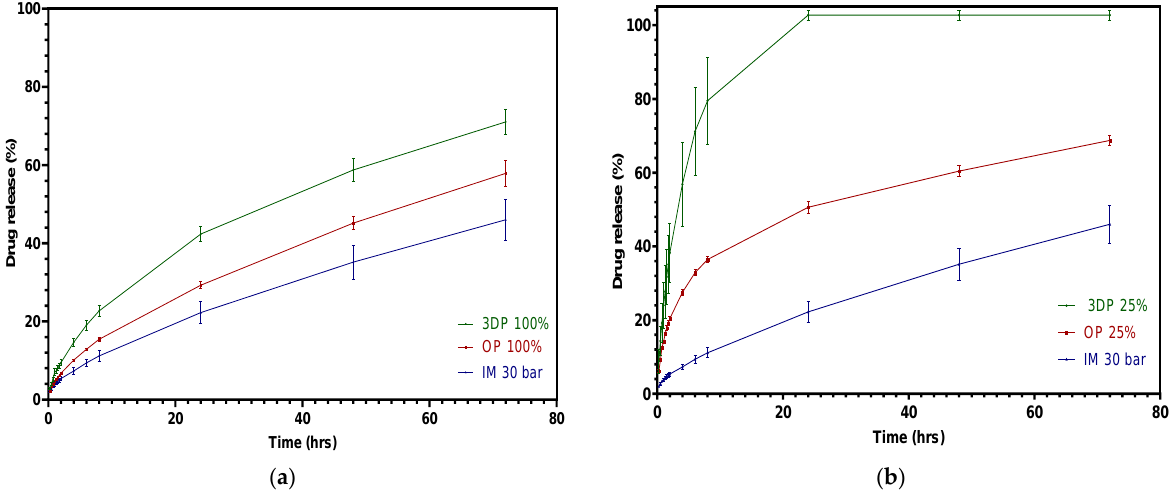
Figure 15. Cumulative theophylline release over 24 h in HCl-KCl pH 1.2 media for tablets: comparison among three different manufacturing approaches. ( a ) Slowest; ( b ) fastest.